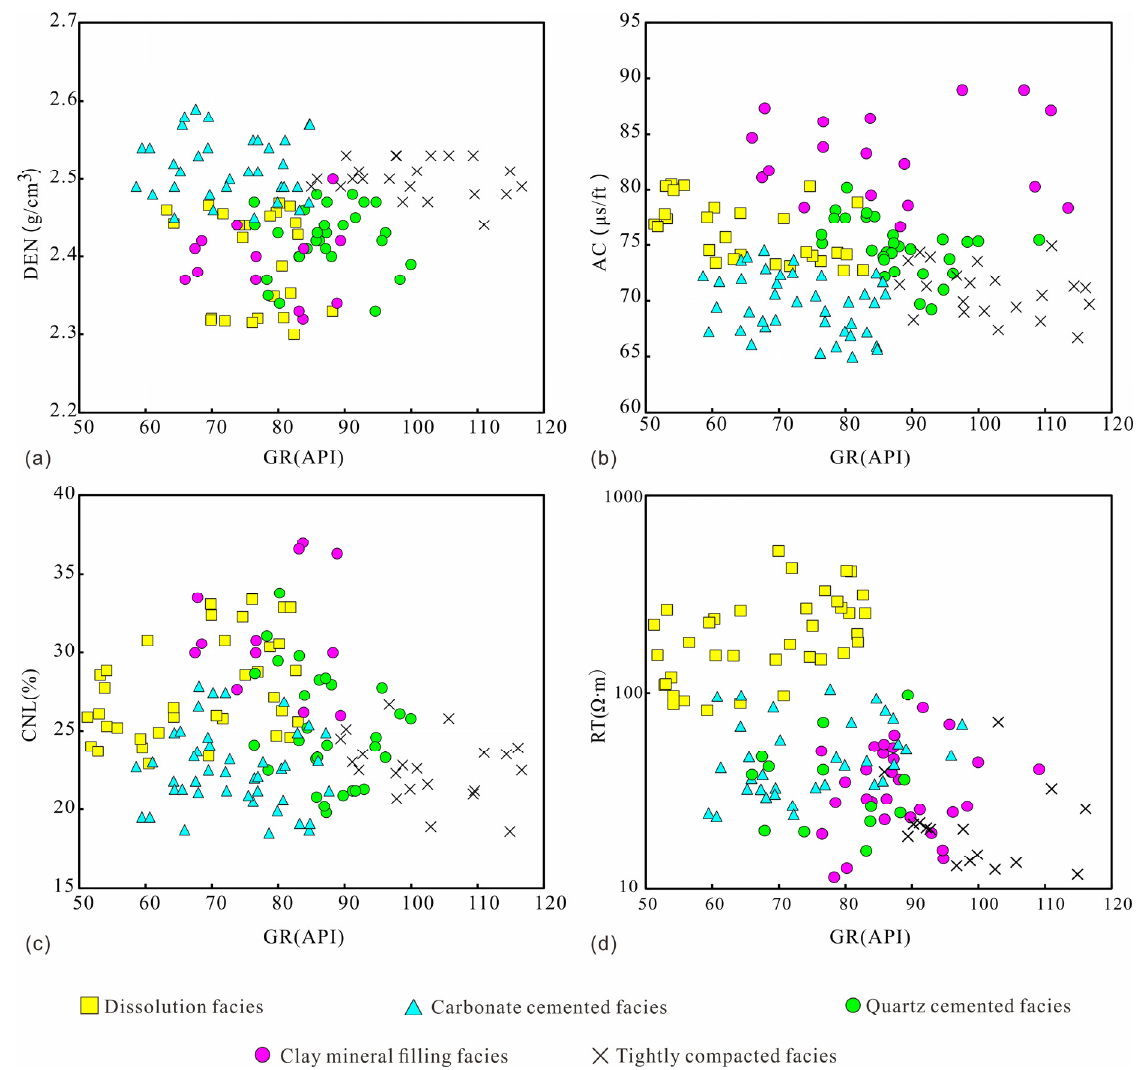
Figure 8. Different diagenetic facies and their well log values. Plots of gamma ray log (GR) versus ( a ) density log (DEN), ( b ) acoustic log (AC), ( c ) compensated neutron log (CNL) and ( d ) resistivity log (RT) values.